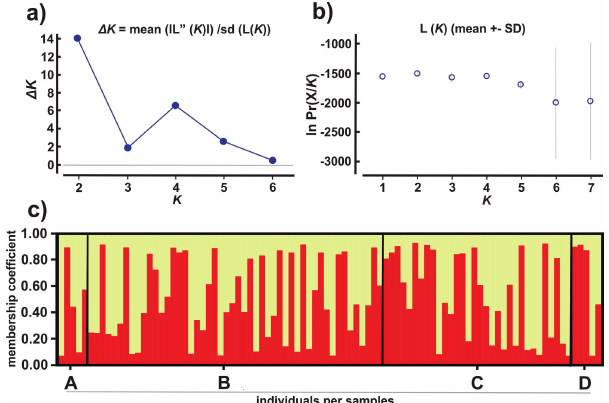
Fig. 2. Bayesian analysis results (Structure). a. Values of K obtained based on Δ K . b. Values of K obtained based on mean likelihood Ln ( K ). c. Graphic representation of K = 2. Each column represents a different individual and the colors denote the probable ancestry coefficient of the individual and each genetic cluster.